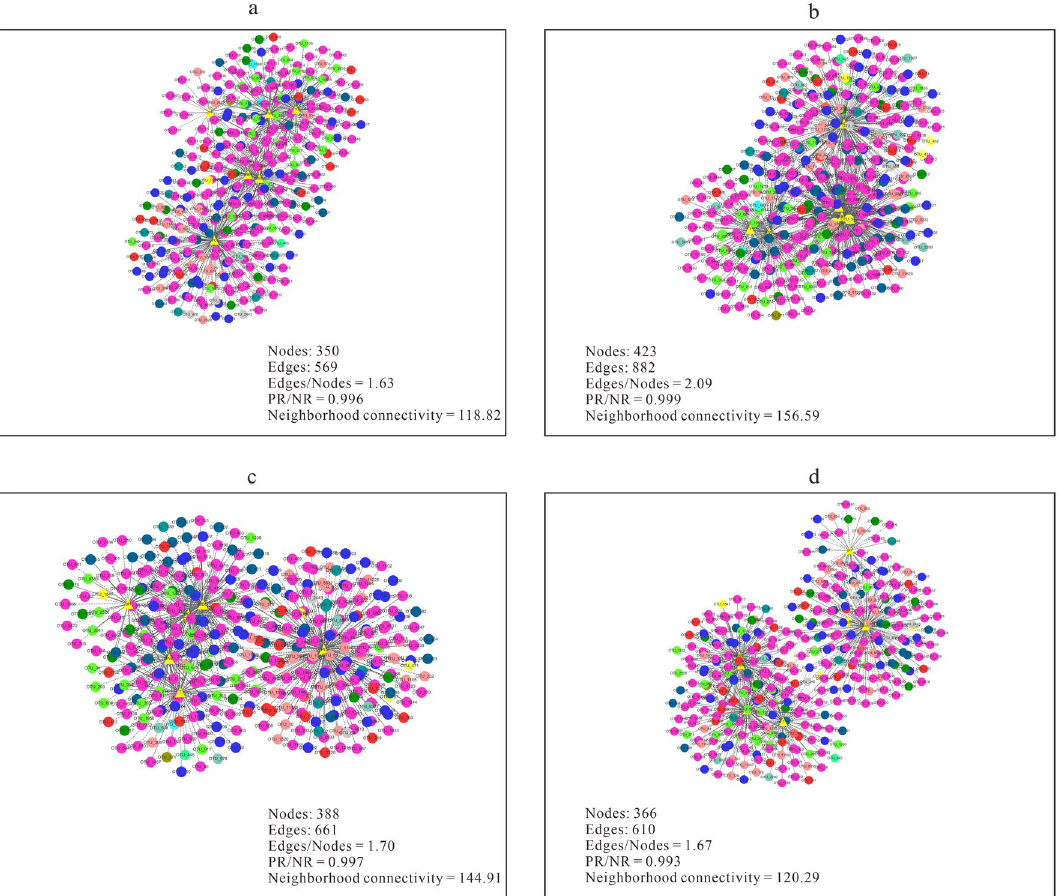
Figure 2. Co-occurrence networks between bacterial OTUs and ecological factors (PW, pH, MBC, MBN, T, and PC) in wheat-cultivated soils ( a ), astragalus-cultivated soils ( b ), potato-cultivated soils ( c ) and angelica- cultivated soils ( d ). The filled colors in nodes indicate phylum level, and the filled yellow color in triangles indicates ecological factors. The solid lines are a positive relationship, and the dashed lines are a negative relationship. Nodes, the number of nodes in a network; edges, the number of edges in a network; edges/nodes, the ratio of edges to nodes; PR, the number of positive relationships; NR, the number of negative relationships; PR/NR, the ratio of PR to NR; neighborhood connectivity, the average neighborhood connectivity of a network. The order of neighborhood connectivity was astragalus (a) > potato (b) > angelica (c) > wheat (c) , with superscript lowercase letters in parentheses representing statistically significant differences under One-ANOVA with Tukey’s test at P < 0.05.